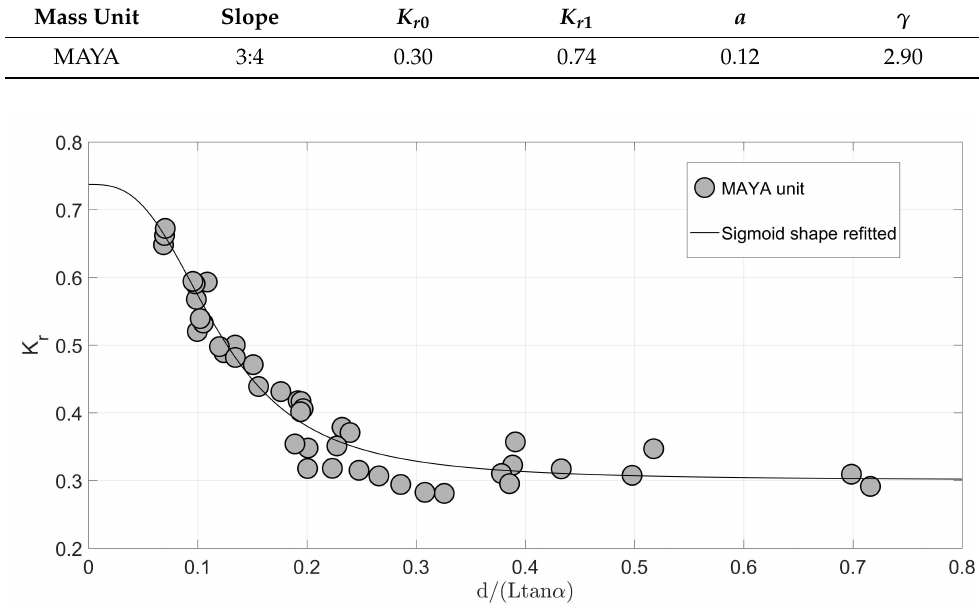
Figure 9. Comparison of MAYA armor units with the refitted sigmoid